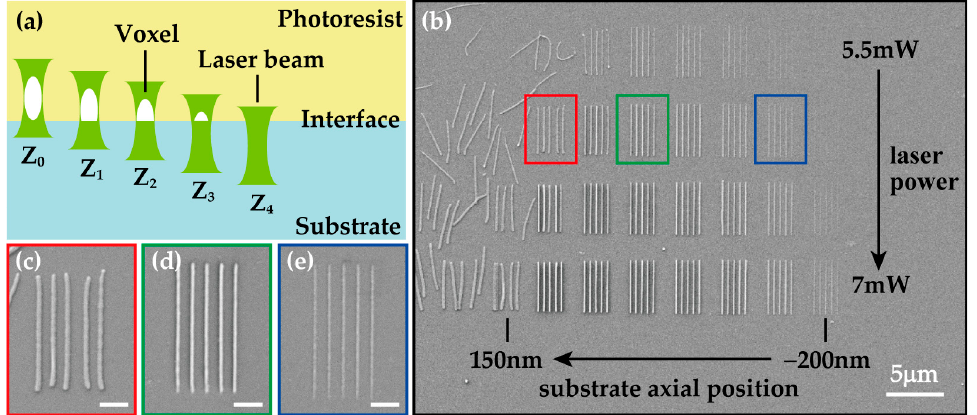
Figure 6. ( a ) Schematic illustration of the variation of the polymerized voxel shapes in different focusing positions ( Z 0 to Z 4 ). ( b ) Grating array produced in different substrate axial positions at a step interval of 50 nm, and with different excitation laser powers at the pupil of the objective lens in steps of 0.5 mW. ( c – e ) Zoomed-in image of a grating structure indicated by the red, green, and blue rectangle in ( b ), respectively. Scale bar: 1 µm.